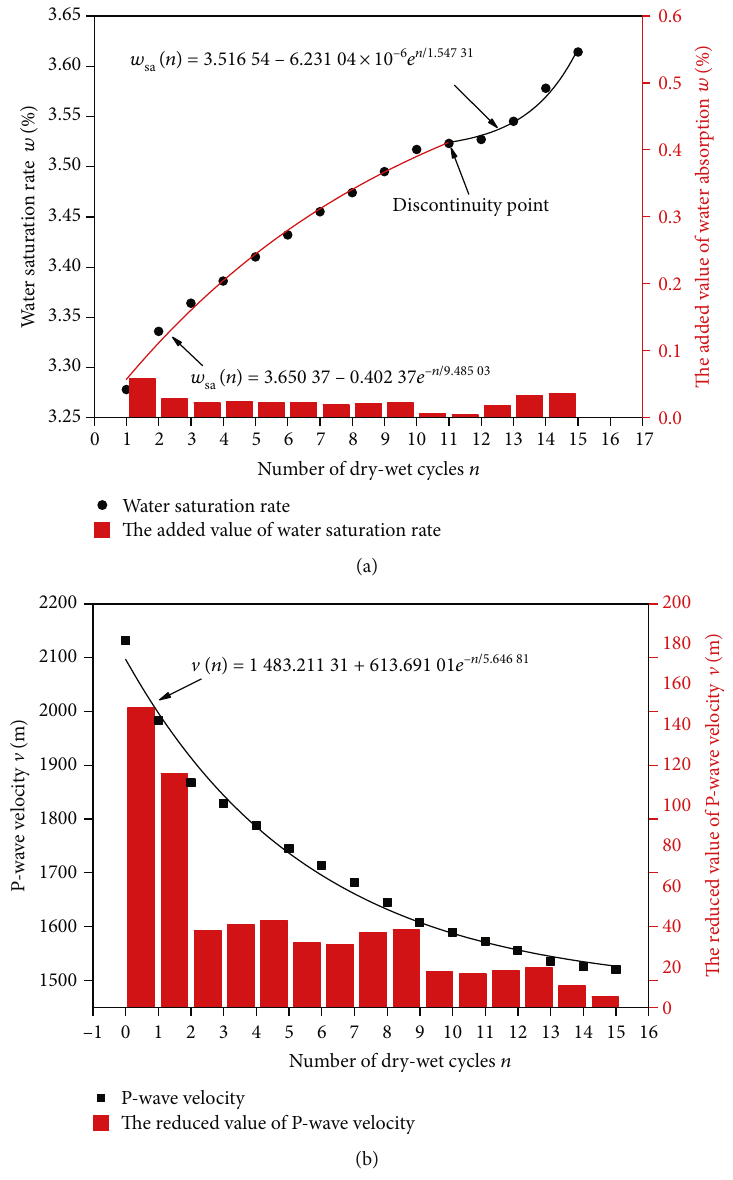
Figure 5: Evolution of sample saturation rate and P-wave